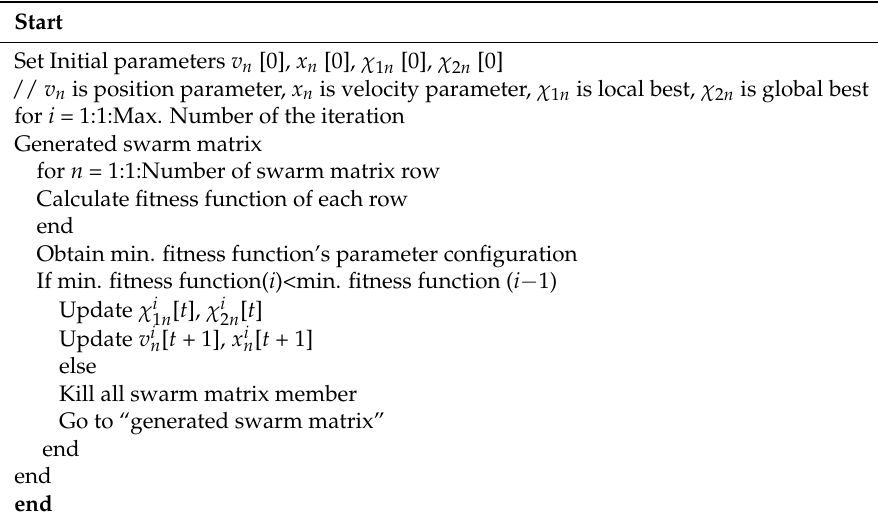
Table 1. Pseudo-code for the fractional-order Darwinian particle swarm optimization (FODPSO)